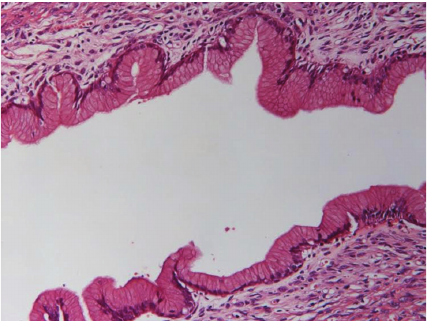
Figure 3: A microscopic picture of the mucinous cystadenoma (expansion × 400). A columnar mucinous epithelium lining cellular